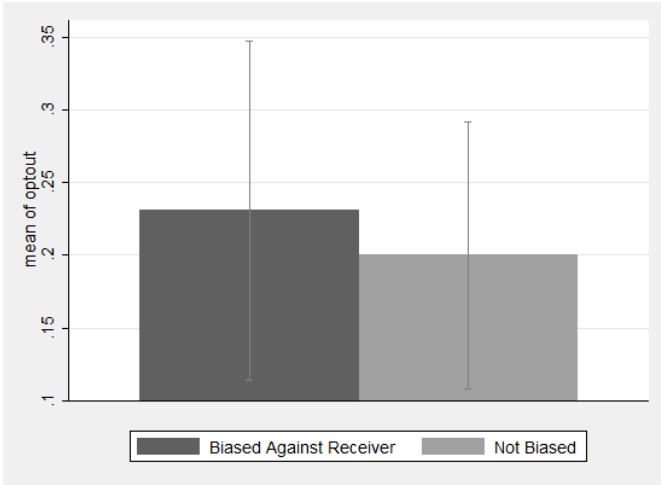
Figure 6. Sorting when the dictator is